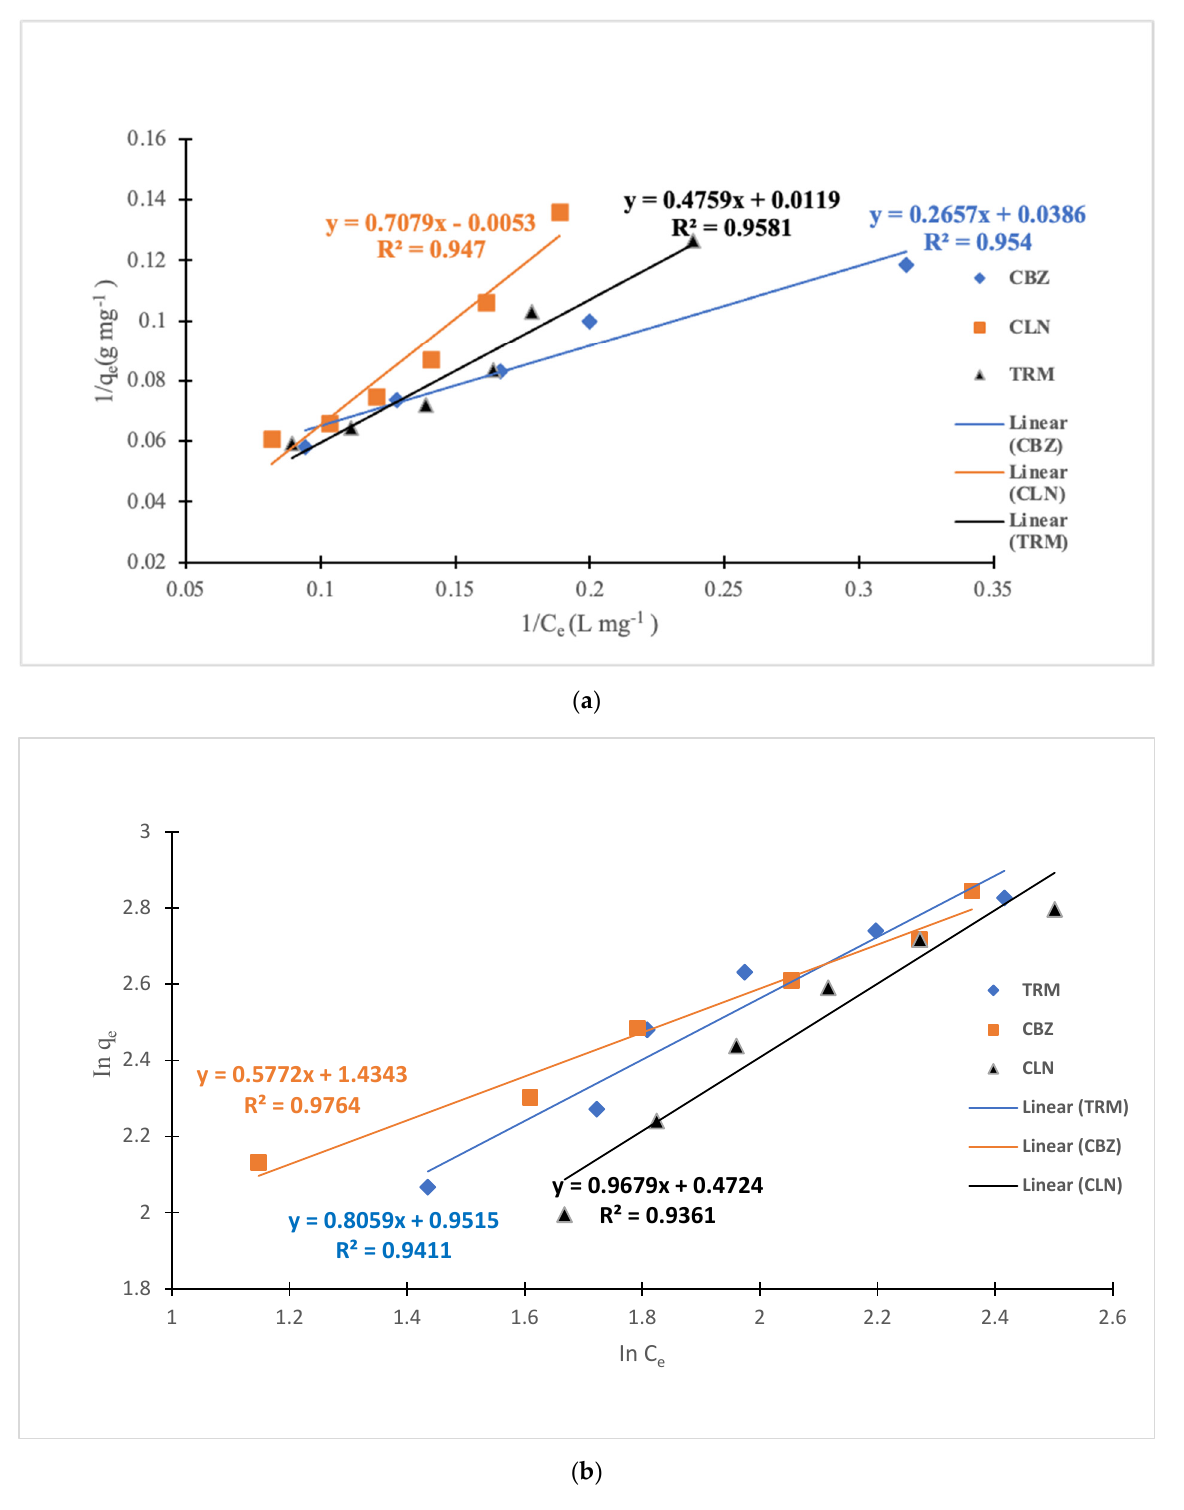
Figure 7. Plots of ( a ) Langmuir and ( b ) Freundlich models for the CPAC on the studied APIs. The affinity rates for the CPAC of the 3 APIs was in the order of CBZ > TRM > CLN based on their K L values. The order of hydrophilicity of the APIs represented by their logD OW shown in Table 2 was TRM > CBZ > CLN. Margot et al. (2013) studied the removal of over 70 APIs using ozone and AC, with the findings showing the most hydrophilic APIs being eliminated to a lesser extent by the AC. Therefore, in line with Margot et al.’s